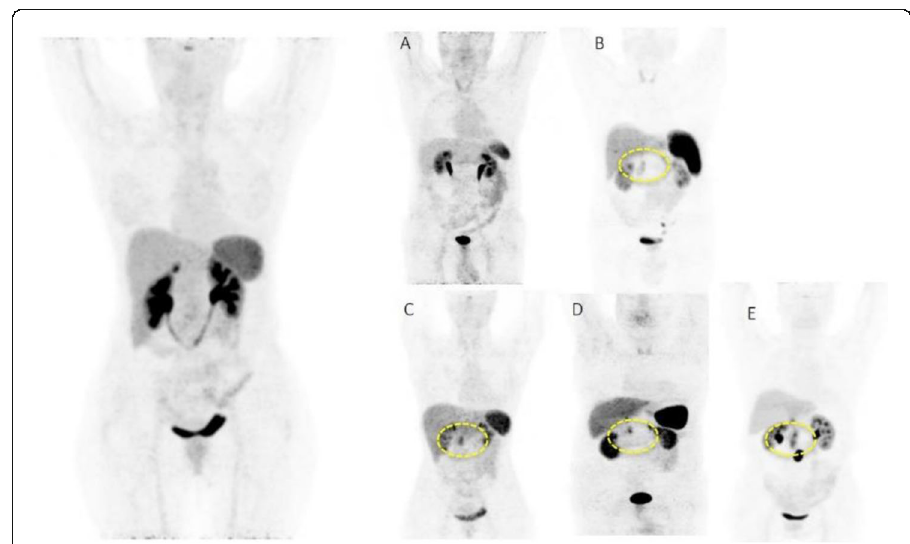
Fig. 46 Physiological bio-distribution of 68Ga-DOTA peptide. Spleen and liver are the organs with the higher uptake of 68 Ga-DOTA peptide. Patterns of increased physiological uptake in the uncinate process of the pancreas (yellow marker): a no uptake, b mild diffuse uptake, c intense diffuse uptake, d intense focal uptake, e diffuse and inhomogeneous uptake